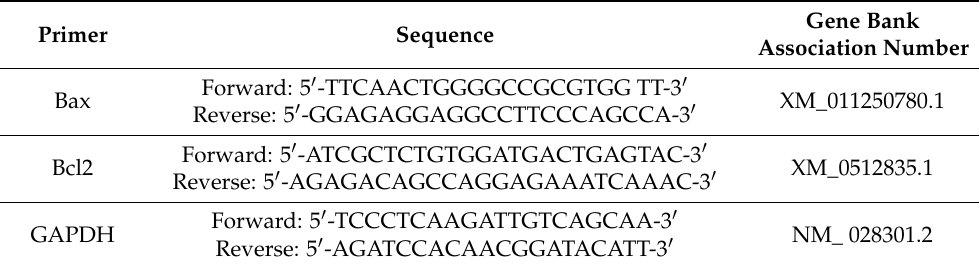
Table 1. The sequences of PCR primer pairs used for Bax, Bcl2, and GAPDH. Primer Sequence